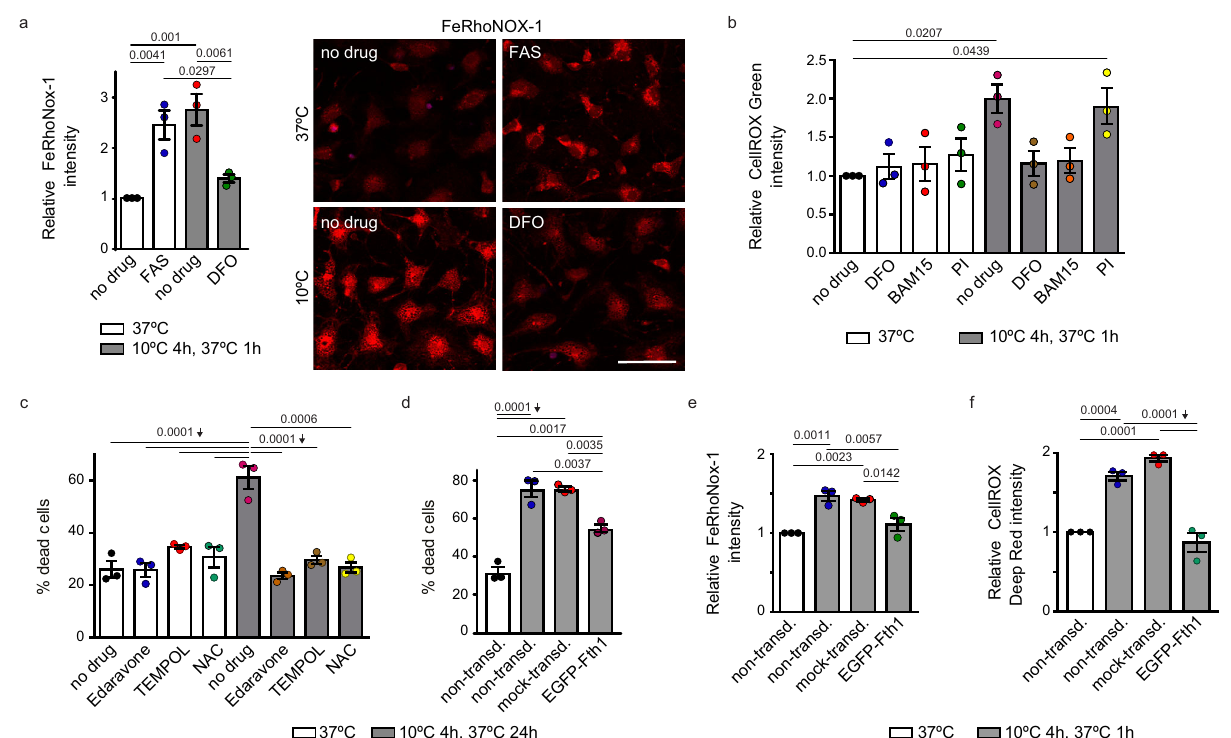
Fig. 9 | The overexpression of FTH1 promotes cold survival, mimicking drugs targetingtheFe(II)-ROSaxis.a Cold-exposedneuronscontainanelevatedlevelof Fe(II).Neuronswereincubatedat37or10°C(4h)with1hrewarming(37°C)inthe absence or presenceofFAS (100 μ M) orDFO(100 μ M).Iron(II)wasdetectedusing FeRhoNox-1. Left: quanti fi cation of FeRhoNox-1 fl uorescence, relative to non- treated cells incubated at 37°C. 150-180 cells were examined per condition. Right: representative images, scale bar: 50 μ m. b Iron chelation and mitochondrial uncoupling decrease ROS levels in cold-treated neurons. Neurons were incubated asin a ,intheabsenceorpresenceofindicateddrugs(concentrationsasinFig.8a). ROS were detected using CellROX Green, and quantitated relative to non-treated cellsat37°C. c Antioxidantsincreasethesurvivalofcold-treatedneurons.Neurons were incubated at 37°C or at 10°C (4h) with 24h rewarming at 37°C, in the absence or presence of Edaravone (50 μ M), N -acetylcysteine (NAC, 10 μ M) or